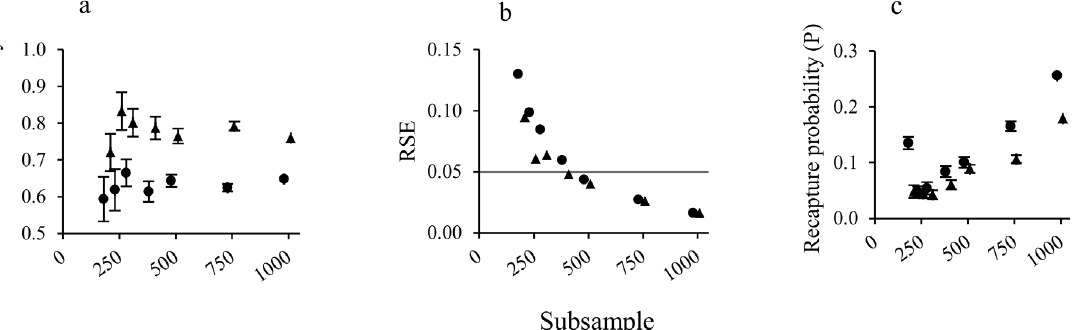
Fig 1. Estimated survival probability (a), RSE of survival probability (b) and recapture (resighting) probability (c) of males ( ● ) and females ( ▲ ) at different levels of subsample size (number of